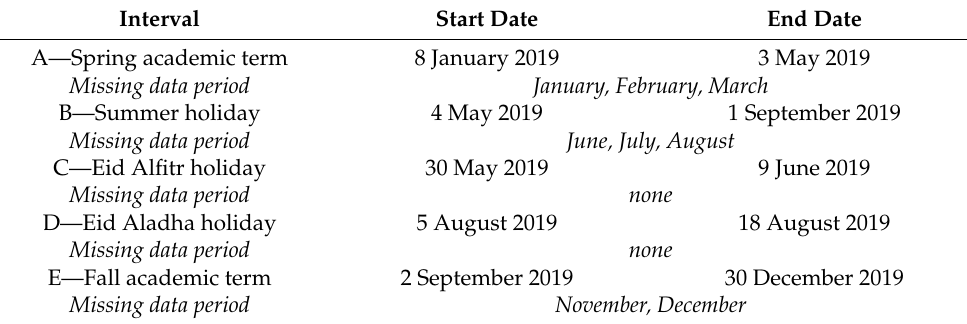
Table 2. UJ different terms and intervals in the year of